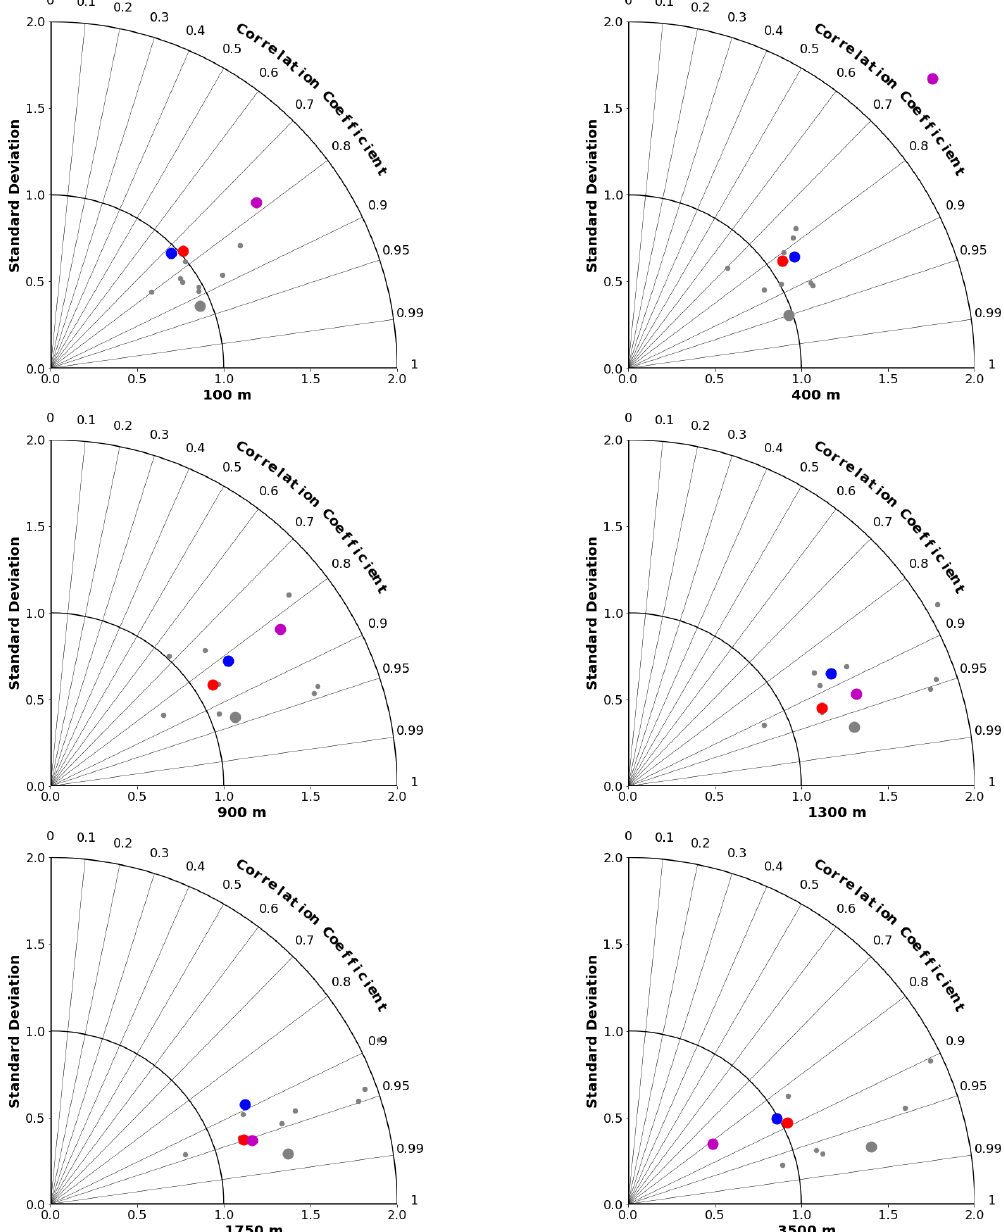
Figure 8. Taylor diagrams comparing modelled and observed distributions of DIC at specific depths from 100 to 3500m. Observations are from GLODAPv2 (Lauvset et al., 2016). Red dots represent CanESM5-CanOE, blue dots CanESM5, magenta dots CanESM2, small grey dots other CMIP6 models, and large grey dots the model ensemble mean for all CMIP6 models except CanESM5 and